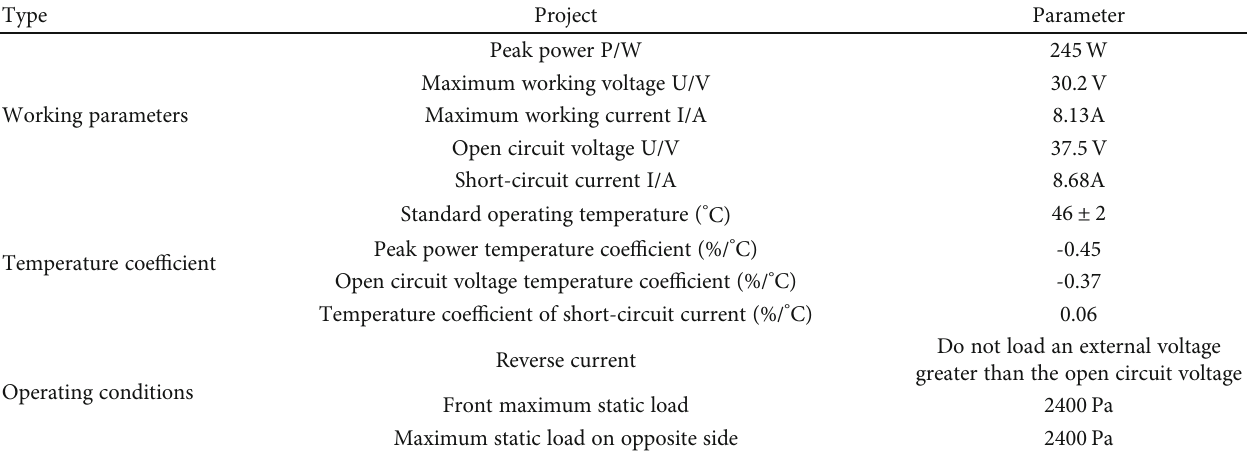
Table 2: Technical parameters of polysilicon photovoltaic cell